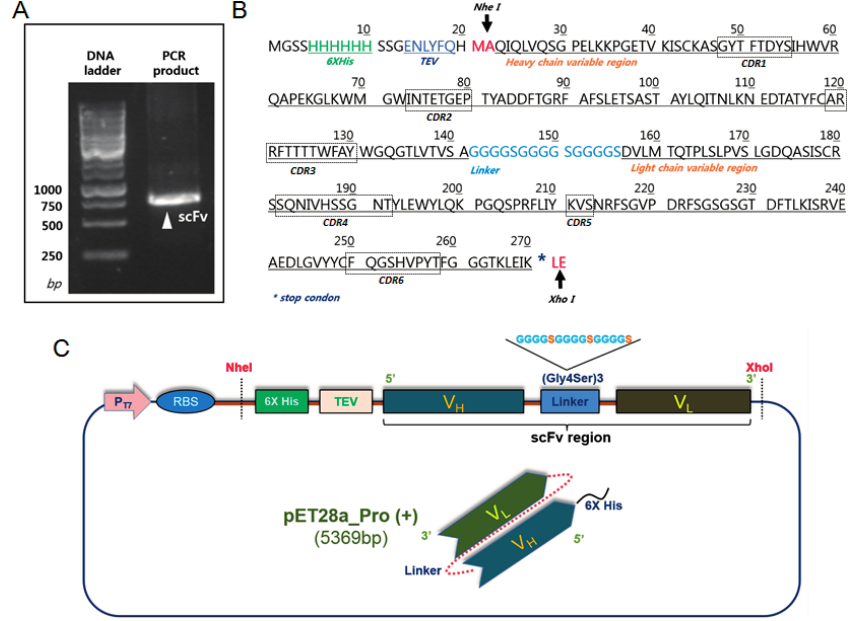
Figure 1. Construction of the premature scFv for protein expression in E. coli . The sequence of the premature scFv with a hexa-histidine tag and a TEV sequence in the N -terminus was shown with a (Gly 4 Ser) 3 linker between the variable heavy ( V H ) and variable light ( V L ) regions. ( A ) The insert of the scFv genes was amplified using PCR; ( B ) The NheI (5') and XhoI (3') restriction enzymes were used for the subcloning; and ( C ) Schematic diagram of the vector plasmid for E. coli expression.